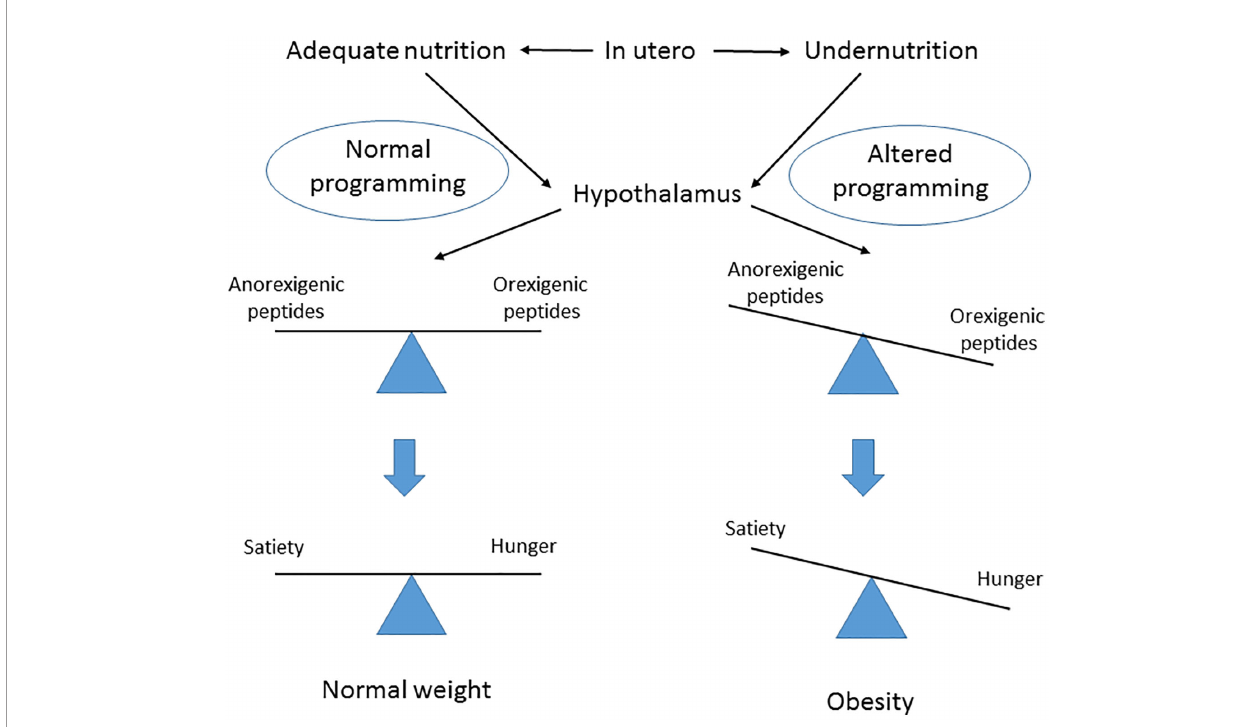
FIGURE 1 | Postulated effect of fetal nutrition in utero on hypothalamus central regulator of obesity programming and subsequent risk later in